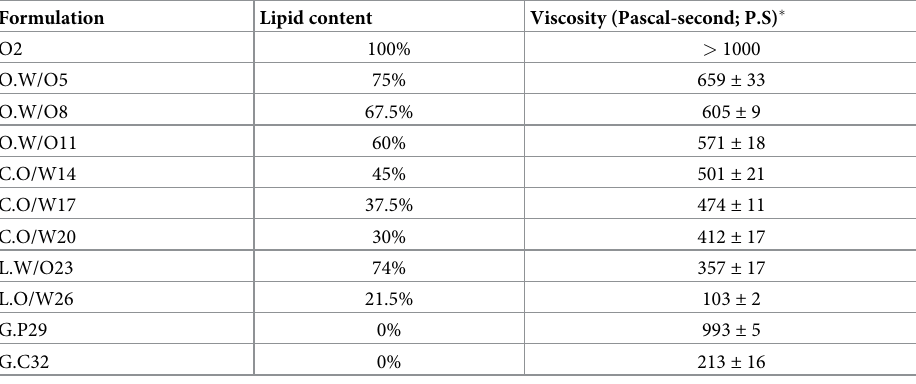
Table 2. The dynamic viscosity of selected